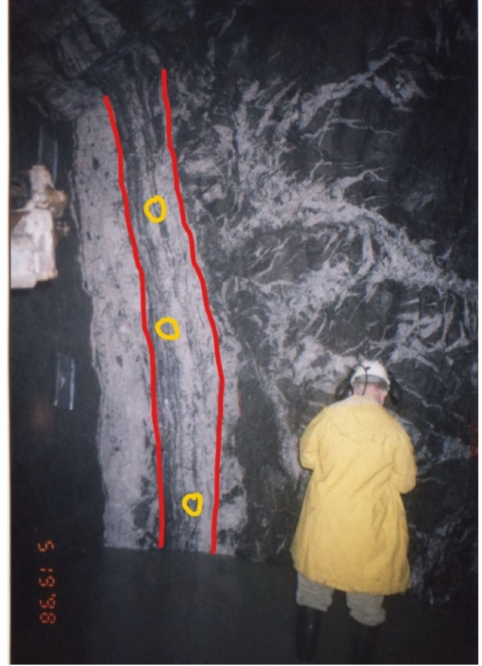
Figure 17. LV (highlighted in red) with spurry veins on its hanging wall. Three theoretical occurrences of potential ultra-high grade are marked for illustration. Occurrences are not necessarily circular. Compare spacing with chip-channel sample collected during mining which was based on a single line across the face.